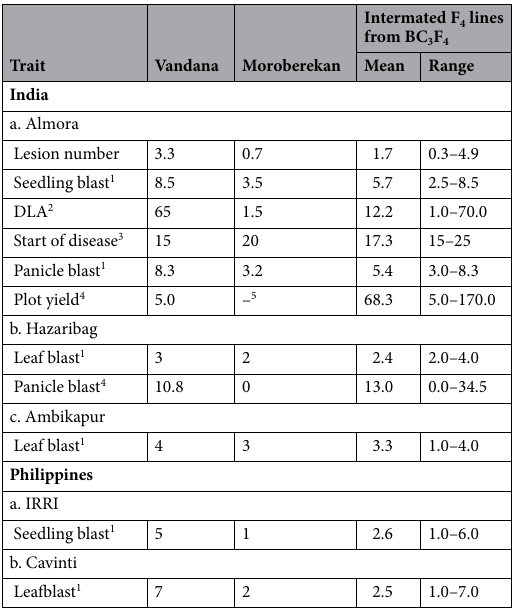
Table 1. Trait mean values for Vandana, Moroberekan and F 4 intermated BC 3 F 4 lines screened for resistance to rice blast at multi-location trials in India and the Philippines. 1 Measure using SES (IRRI, 1996) Scale 0–9. 2 DLA Diseased leaf area (%) at seven weeks after sowing. 3 Days after sowing. 4 Plot yield (grams per plot) under field rice blast infection. 5 Data not available. 6 Panicle blast severity measured